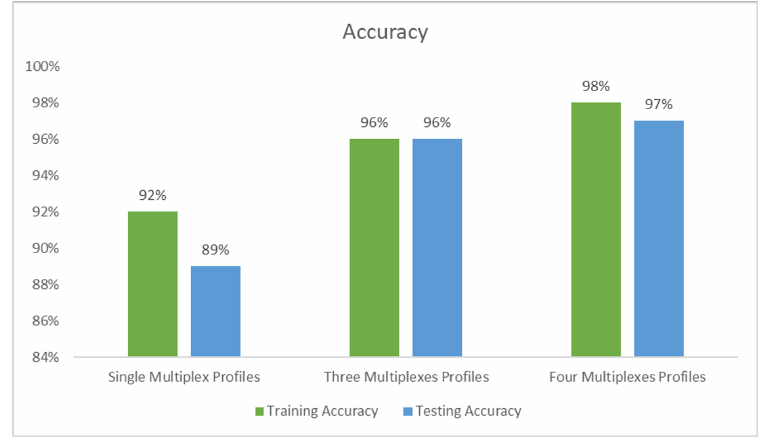
Figure 29. Prediction accuracy: comparison of single, three, and four multiplex profiles.